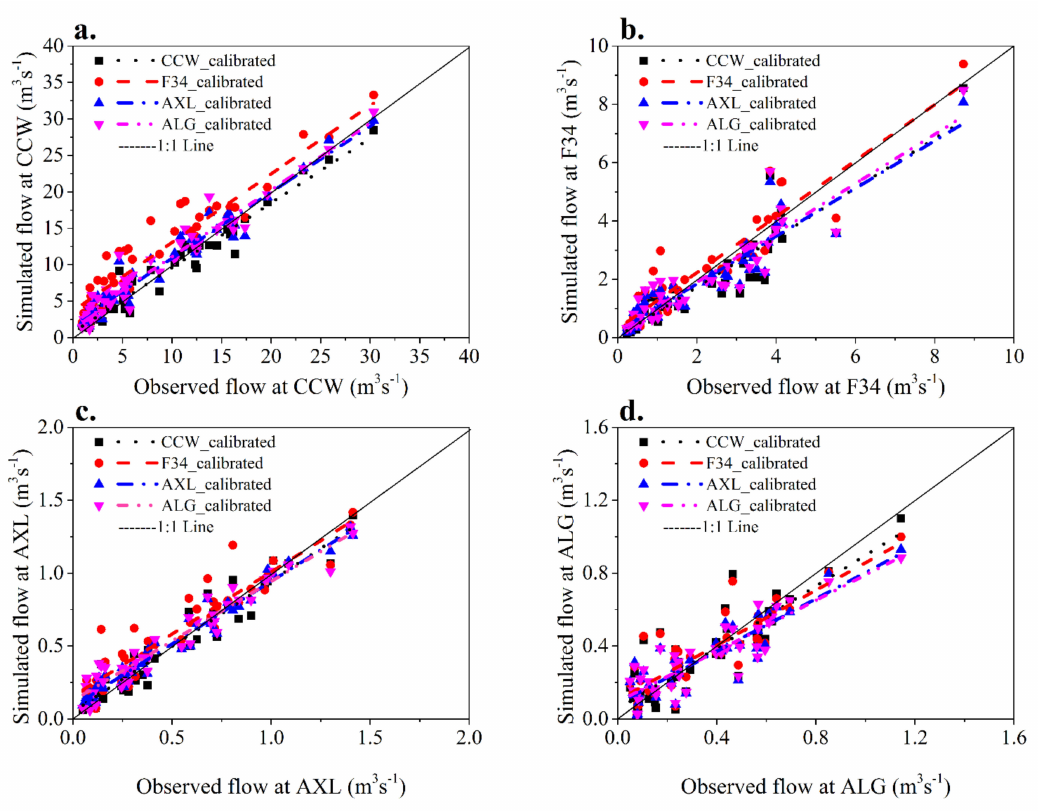
Figure 3. One-to-one plots of SWAT simulated vs. observed monthly streamflow at the ( a ) CCW outlet, ( b ) F34 outlet, ( c ) AXL outlet, and ( d ) ALG outlet for the calibration period from January 2006 to December